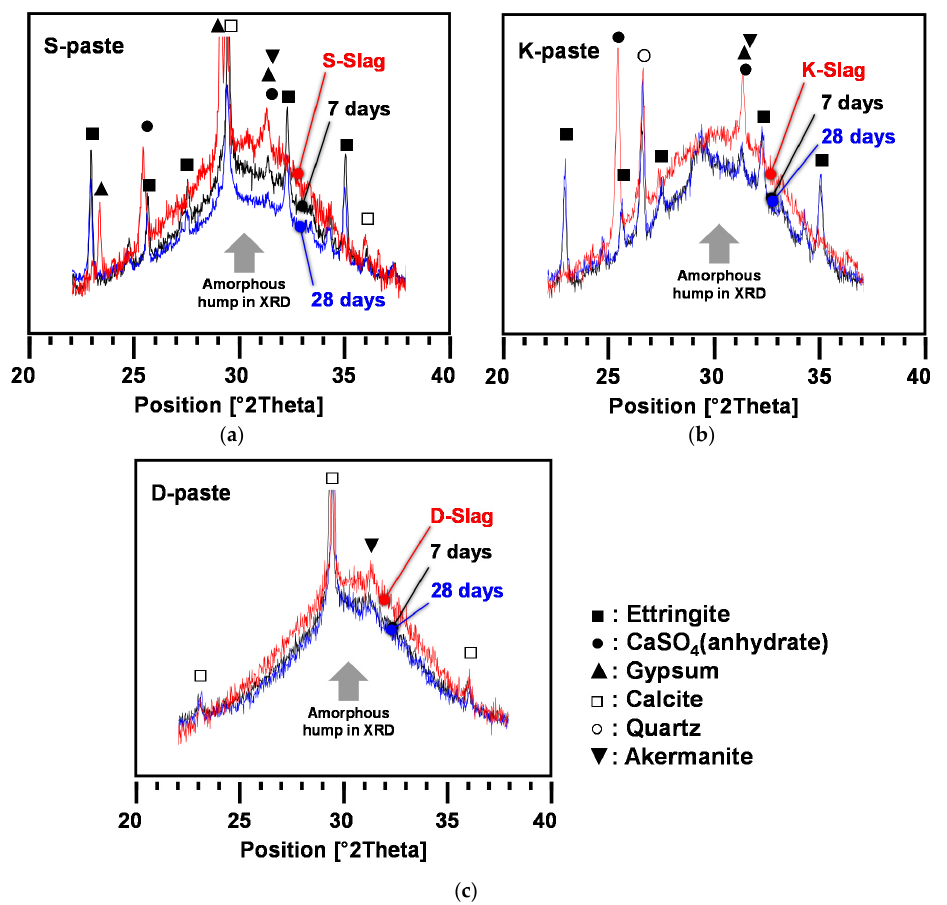
Figure 6. Gradual reduction of GGBFS glass phase with curing days. ( a ) S ‐ paste; ( b ) K ‐ paste; ( c ) D ‐ paste.